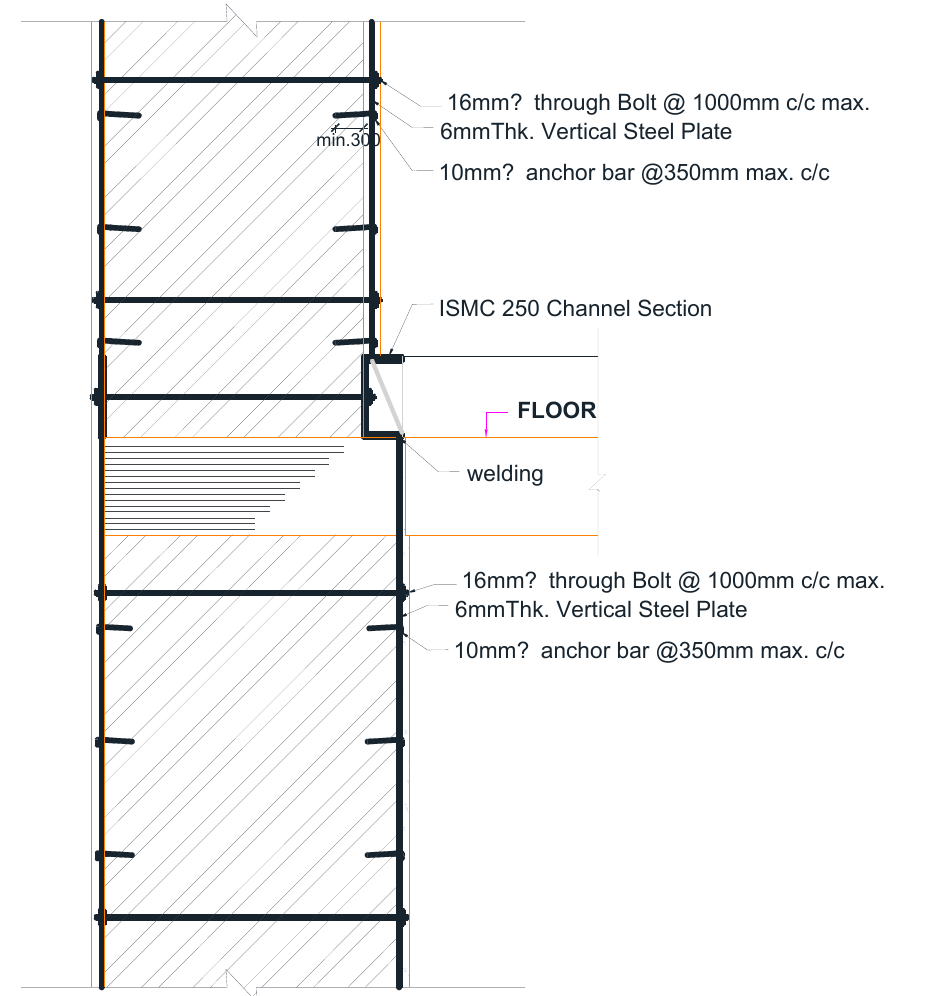
Figure 11. Details of band per floor.